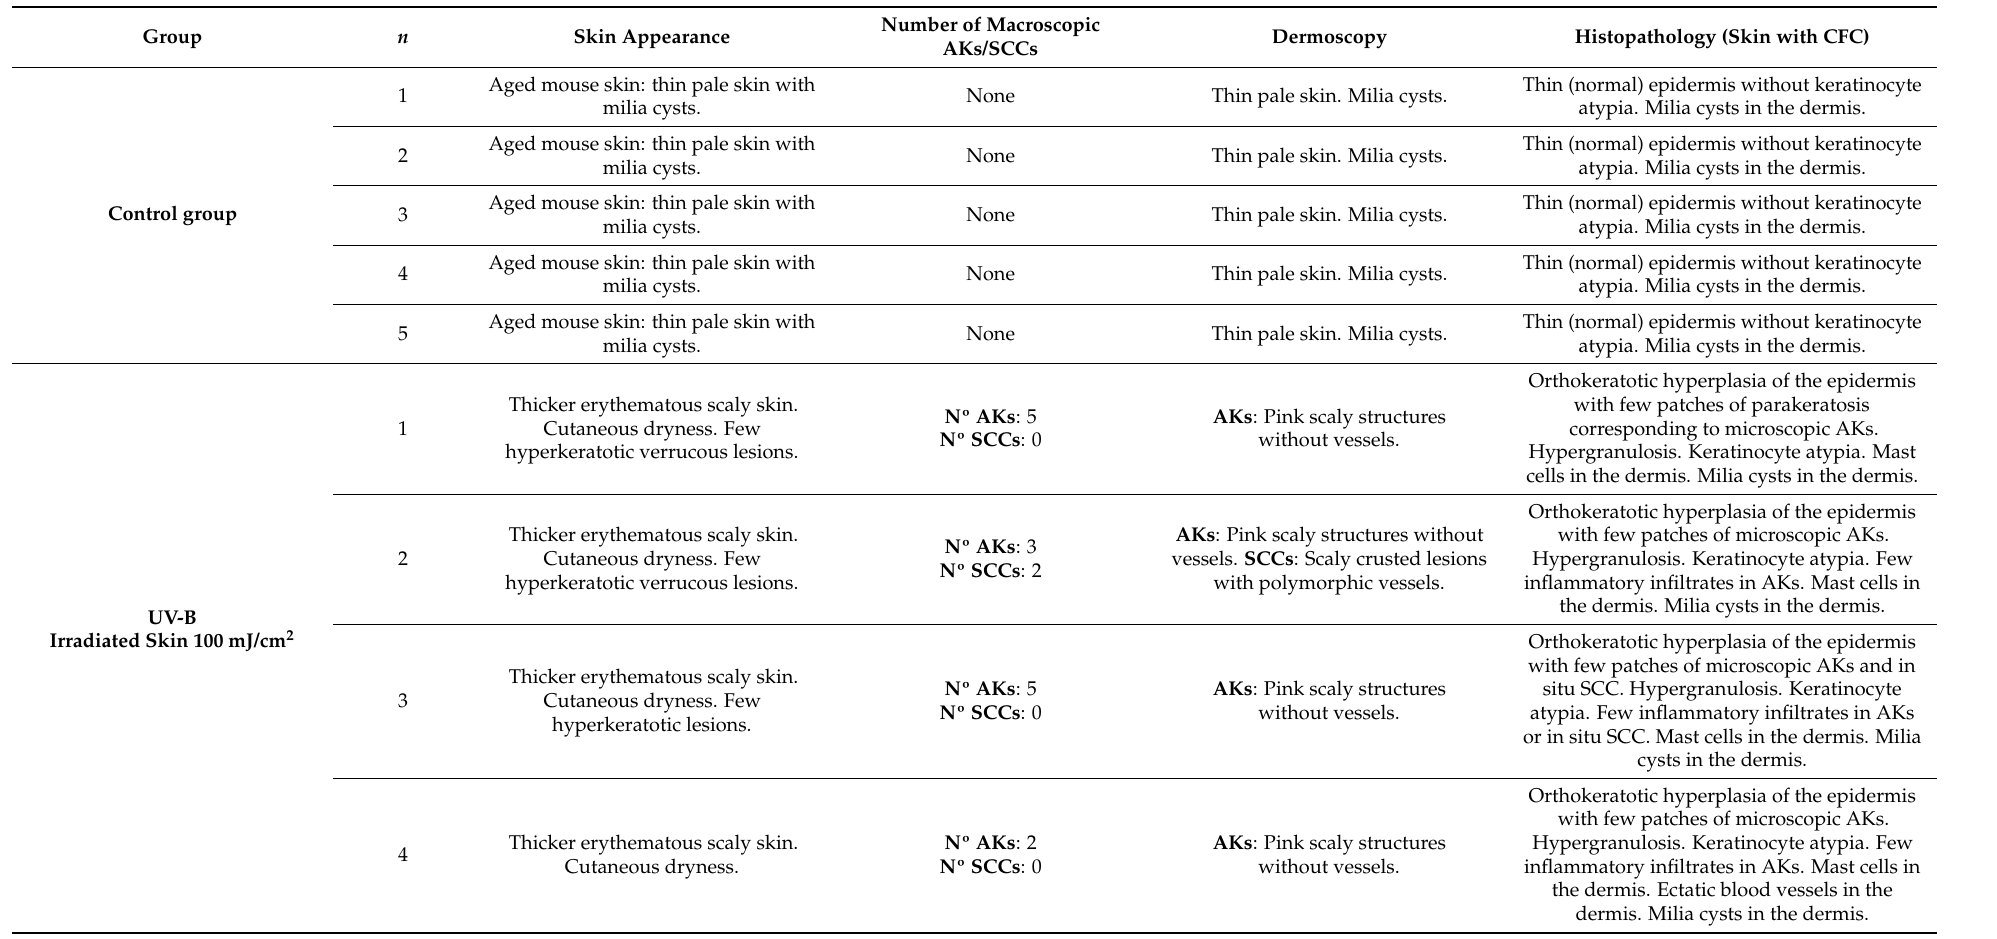
Table A1. Naked eye, dermoscopic, and histopathological features in the UV-B-irradiated groups compared to the nonirradiated group. Group n Skin Appearance Aged mouse skin: thin pale skin with 1 milia cysts. Aged mouse skin: thin pale skin with 2 milia cysts. Aged mouse skin: thin pale skin with Control group 3 milia cysts. Aged mouse skin: thin pale skin with 4 milia cysts. Aged mouse skin: thin pale skin with 5 milia cysts. Thicker erythematous scaly skin. 1 Cutaneous dryness. Few hyperkeratotic verrucous lesions. Thicker erythematous scaly skin. Cutaneous dryness. Few hyperkeratotic verrucous lesions. UV-B Irradiated Skin 100 mJ/cm 2 Thicker erythematous scaly skin. Cutaneous dryness. Few hyperkeratotic lesions. Thicker erythematous scaly skin. Cutaneous dryness.